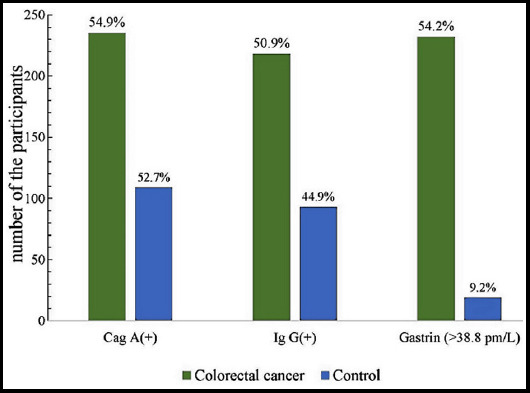
The distribution of the patients with Cag A (+), Ig (+) and the level of gastrin higher than 38.8pm/L in the two groups.